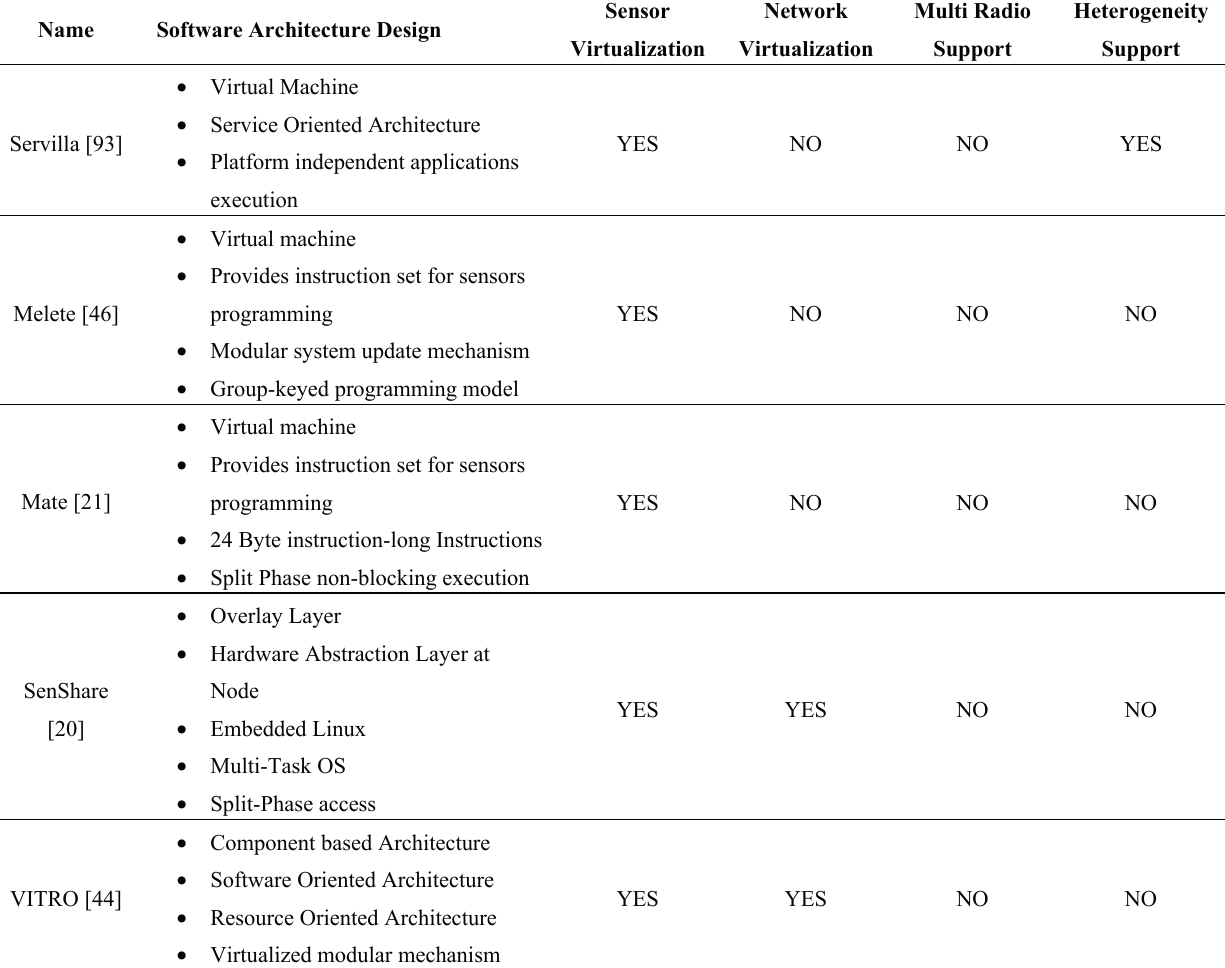
Table 1. Middleware architecture design and WSN virtualization